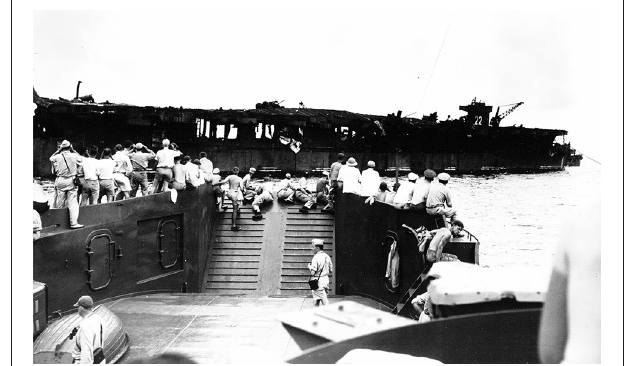
FIGURE 2 | Inspection teams and media approach Independence after Test Able, July 1, 1946 (U.S. National Archives).